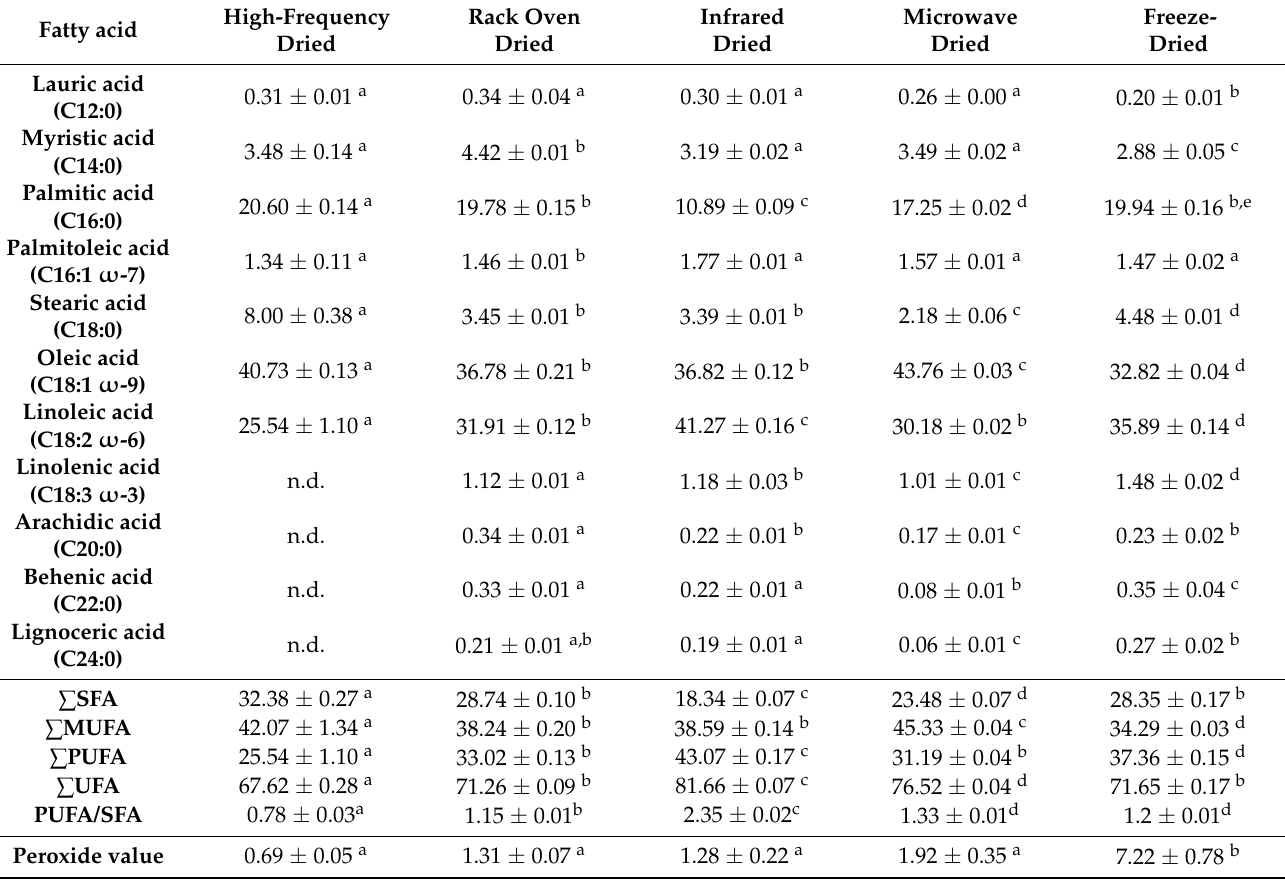
Table 4. Fatty acid composition of dried mealworm